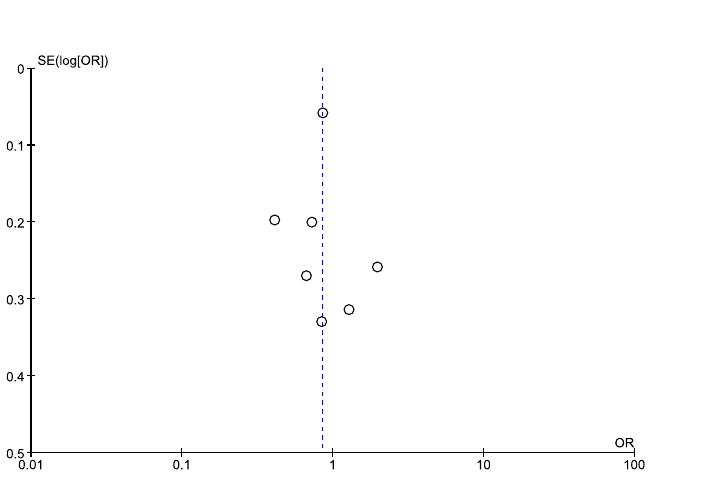
Figure 4. Funnel plot demonstrating publication bias among the included